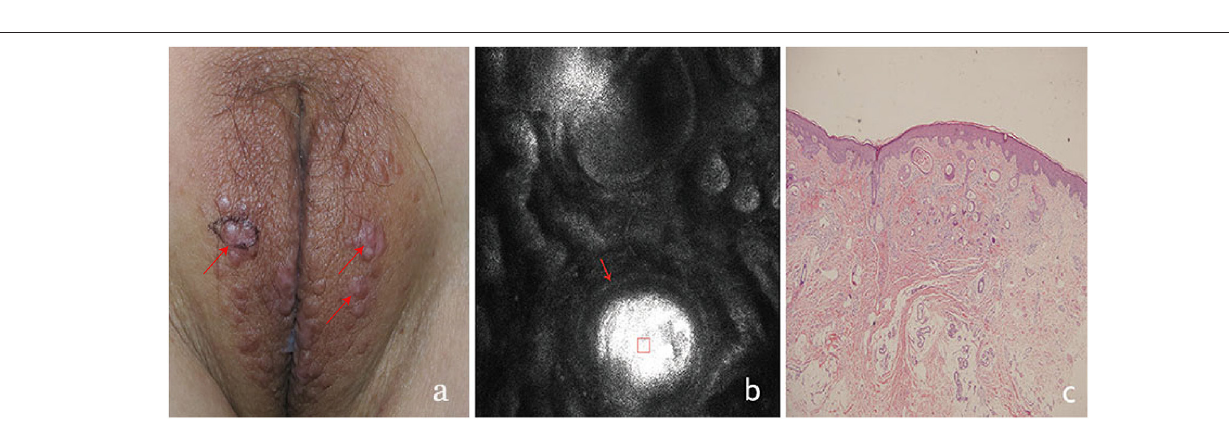
FIGURE 2 | The clinical presentation, RCM findings and histology of vulva syringoma (case 2). (a) , the clinical image of case 2, (b) , the RCM image findings; (c) , the histological findings. The presence of round to oval high refractive, and relatively monomorphous mass of varing sizes (the red square) was present in the superficial dermis, with 1–2 layers of surrounding light-dark line structure (red arrowhead) in (b)